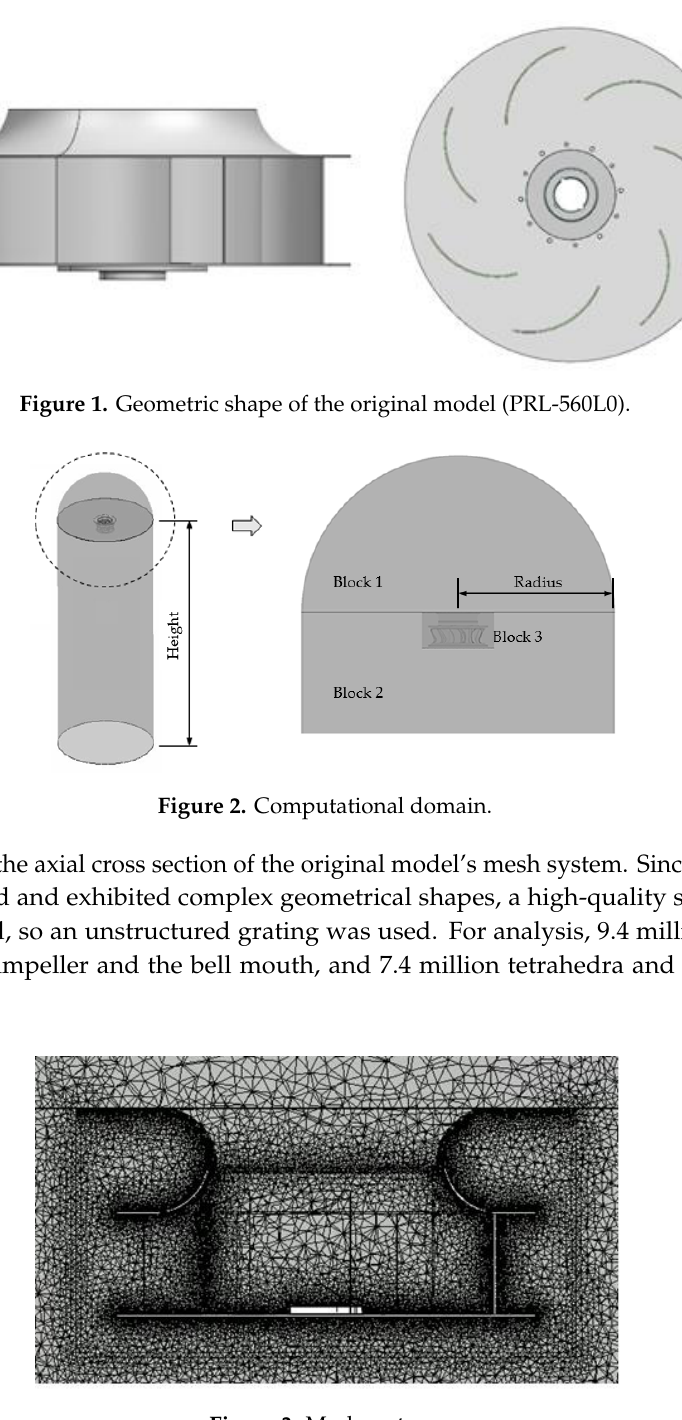
( b ) Figure 4. ( a ) Schematic diagram of multi-nozzle chamber; ( b ) Test scene. Figure 5 shows that the CFD results and the experimental results are in good agreement with the rated airflow rate and the static pressure conditions. Figure 5. Comparison between the numerical and experimental results (at 1100 rpm) 3. Optimization of the Blade Profile